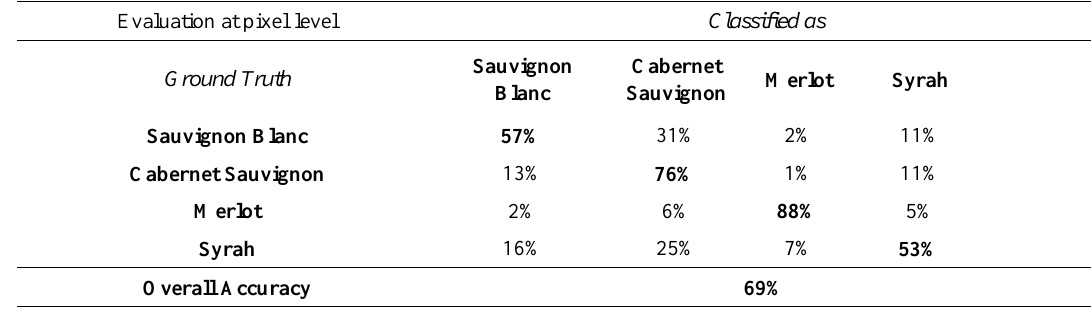
Table 2. Quantitative evaluation results at pixel level for the Megaplatanos study